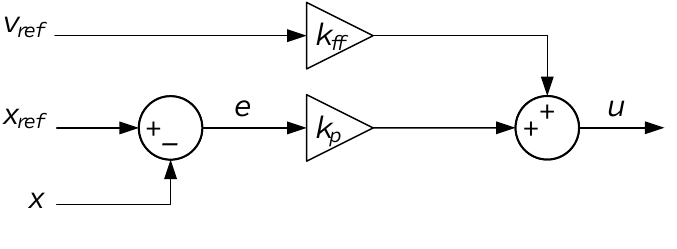
Figure 3. Feedforward with fixed gain.